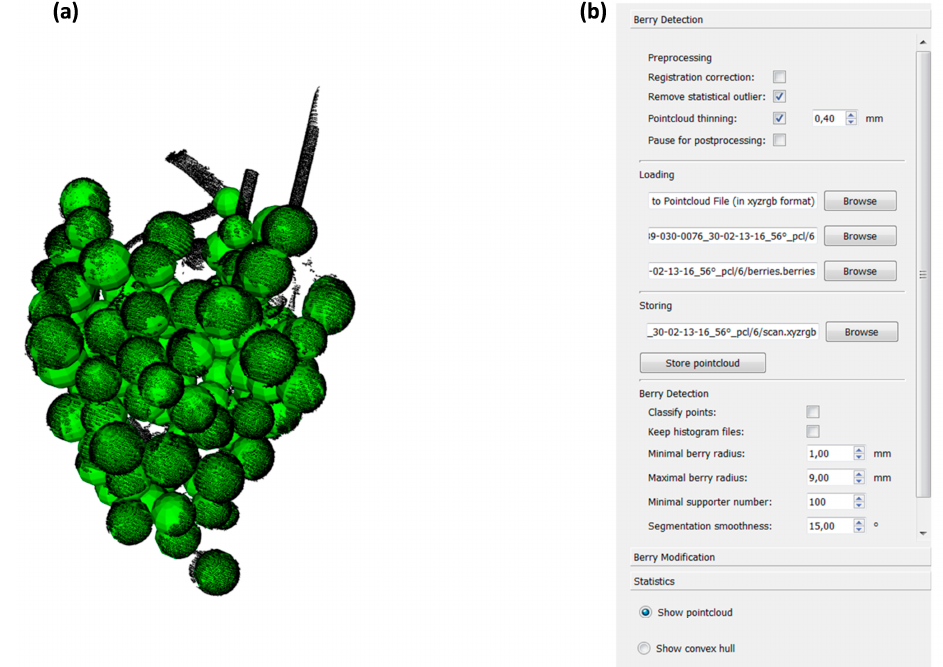
Figure 3. Graphical User Interface (GUI) of 3D-Bunch-Tool (3D-BT). The viewport of grape bunch reconstruction is shown. Detected berries are shown as green spheres ( a ). The settings field is located on the right side of the GUI with adjustable parameters ( b